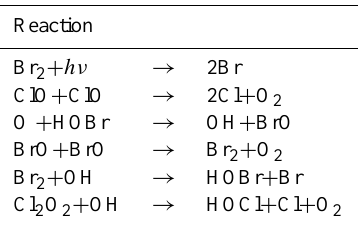
Table 1. List of new gas-phase and photolysis reactions compared to Wohltmann et al.